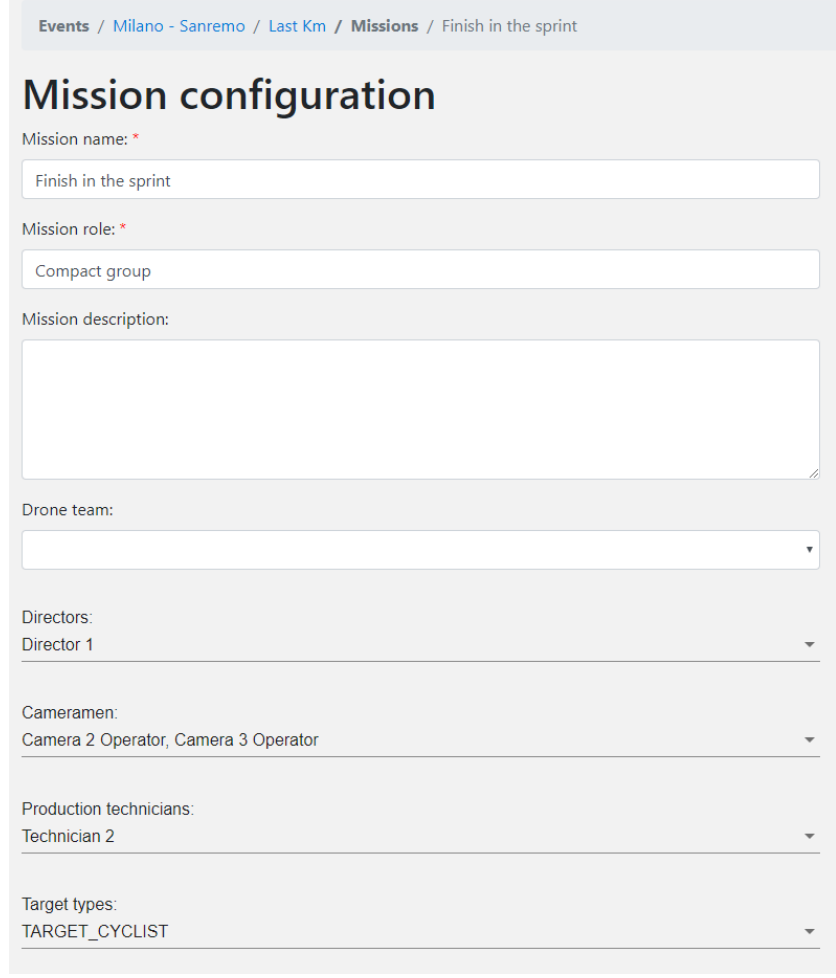
Figure 6. Example screenshot of the mission configuration page. The people and drone team involved can be